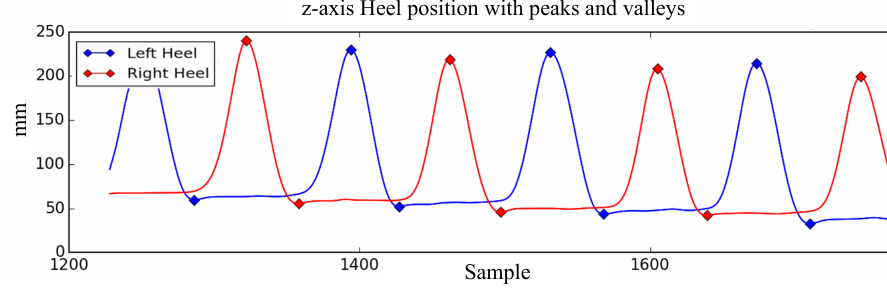
Figure 5. Peaks and valleys of z-axis heel